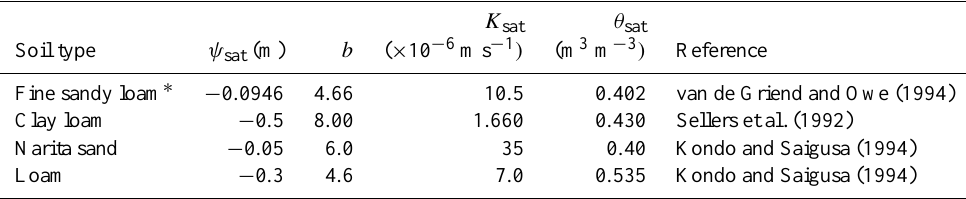
Table 2. Clapp and Hornberger (1978) parameters for the topsoil used in Table 1.